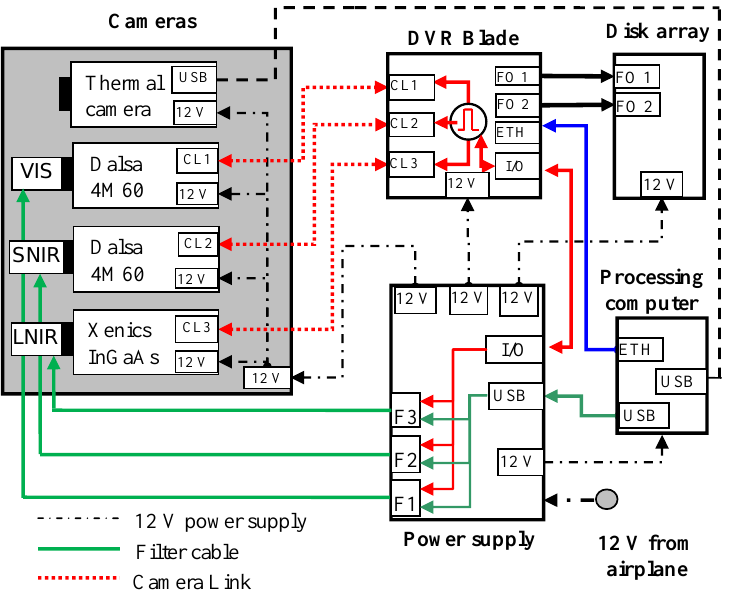
Figure 1. Apparatus with interference filters.